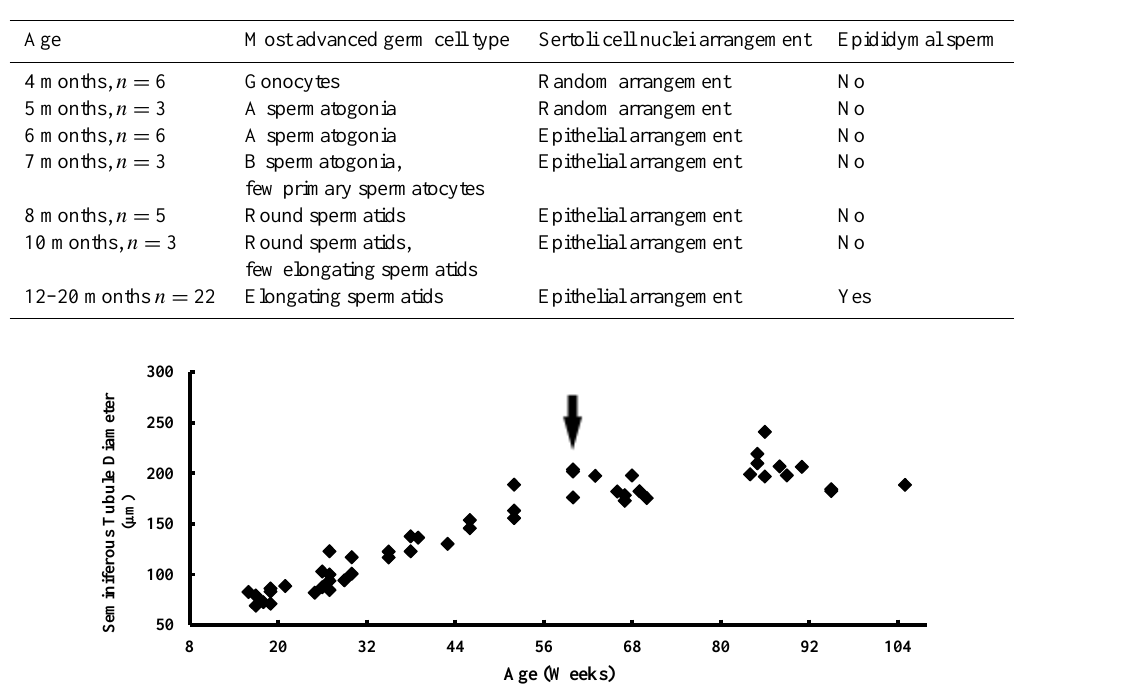
Table 1. Description of advanced germ cell type, Sertoli cell arrangement and the presence or absence of sperm in the epididymis of common marmosets over the course of development ( n = 48).